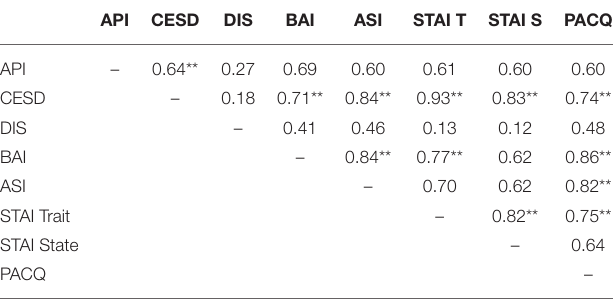
TABLE 3 | Correlations between pre-measure